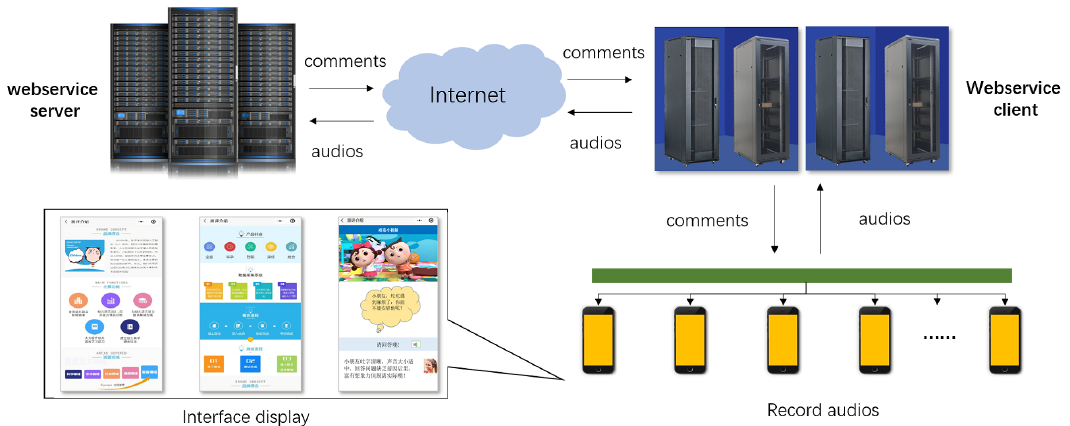
Figure 8. The way the third-party users to access the proposed model for an oral